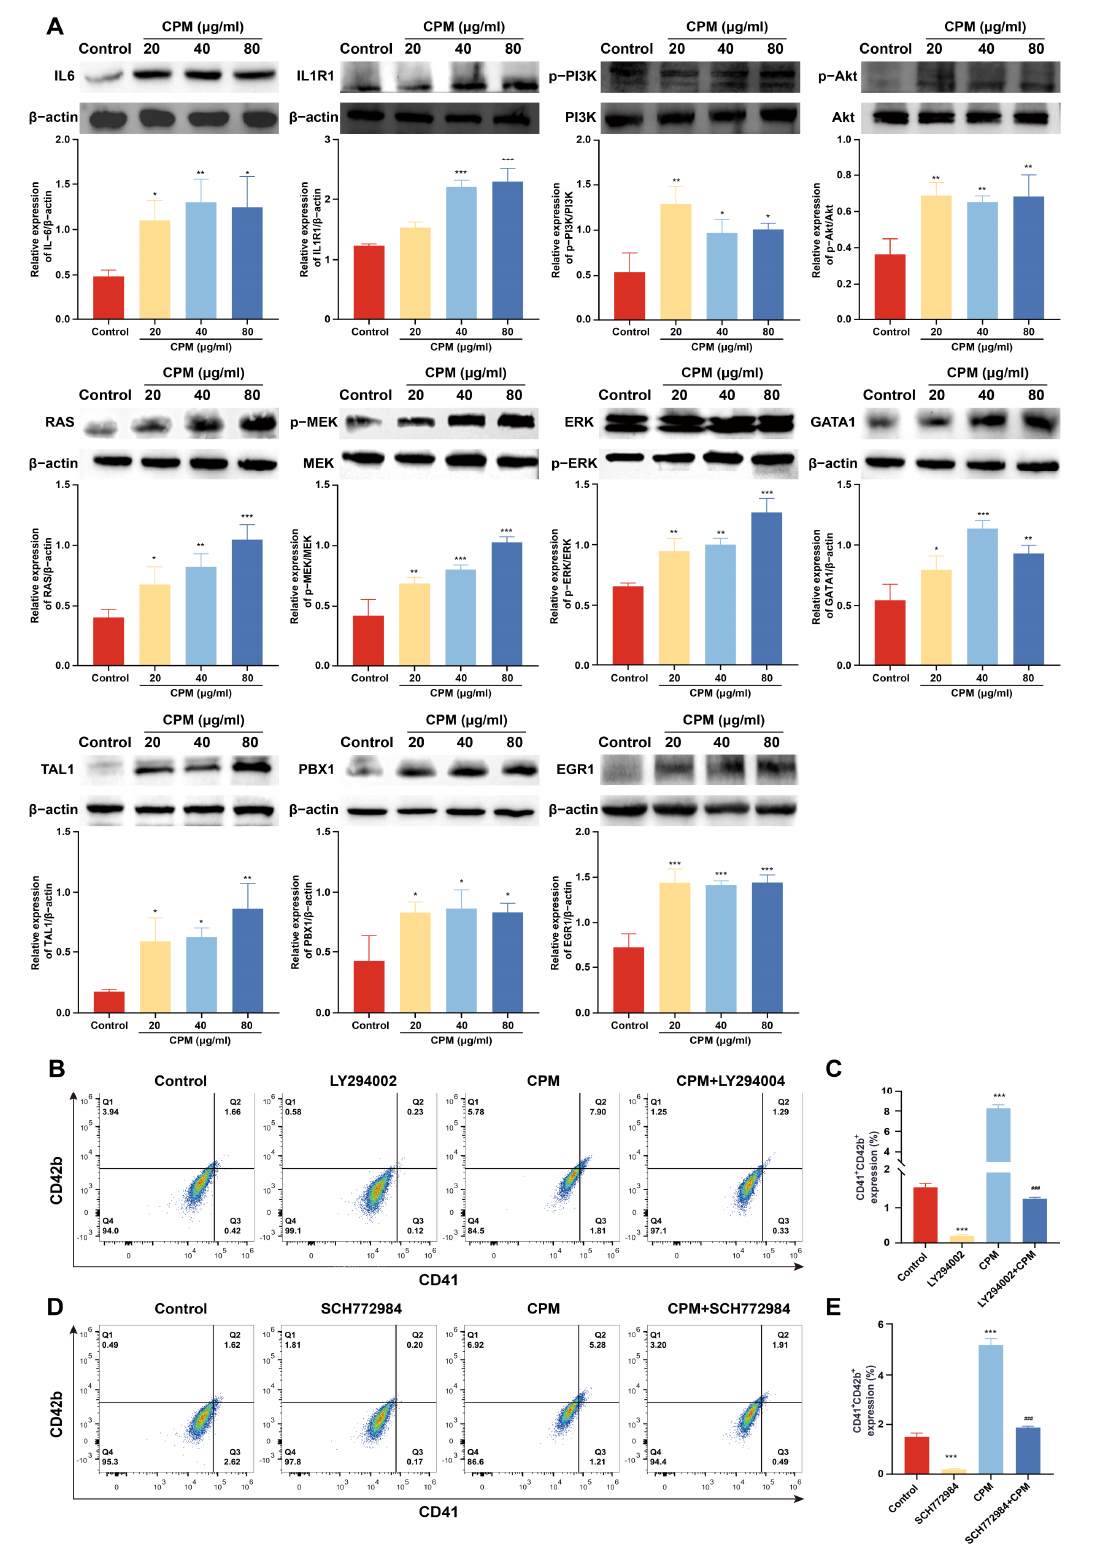
Figure 6. CPM induces MK differentiation through activating PI3K/Akt and MEK/ERK signaling pathways. ( A ) The measurement of proteins belonging to PI3K/Akt and MEK/ERK signaling pathways and hematopoietic TFs by western blot in control and CPM (20, 40 and 80 µ g/mL)-treated groups on K562 cells. The data are the mean ± SD (n = 3). * p <0.05, ** p <0.01, *** p < 0.001 vs.